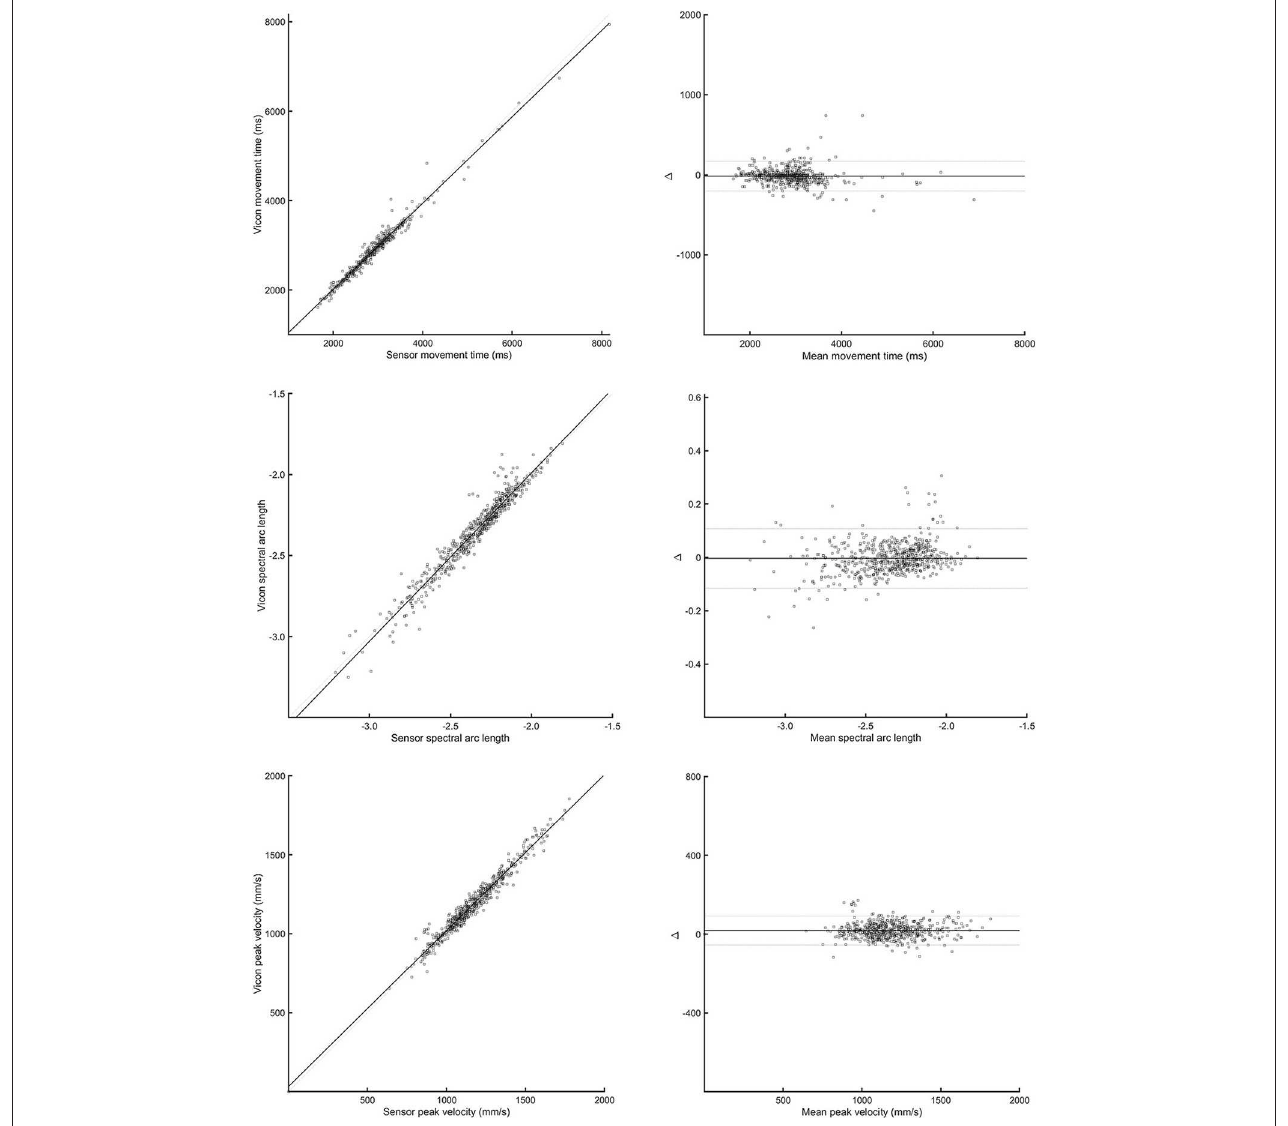
FIGURE 4 | Correlation (left panels) and Bland-Altman plots (right panels) between the outREACH sensor and Vicon for the Block task. The top-most panels refer to differences in movement time values, middle panels refer to differences in spectral arc length values, and the lower-most panels refer to differences in peak velocity